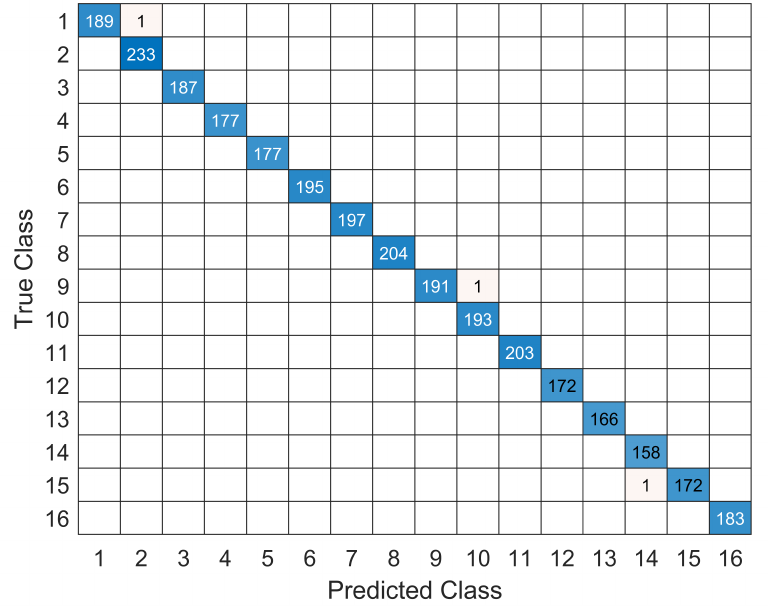
Figure 6. The confusion matrix of the true and predicated class of the model.